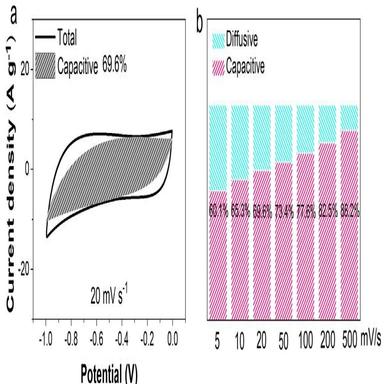
(a) Capacitive contribution of SrFe12O19 NR/G-29.7 at 20 mV s1 and (b) capacitive contribution of SrFe12O19 NR/G-29.7 at various sweep rates.